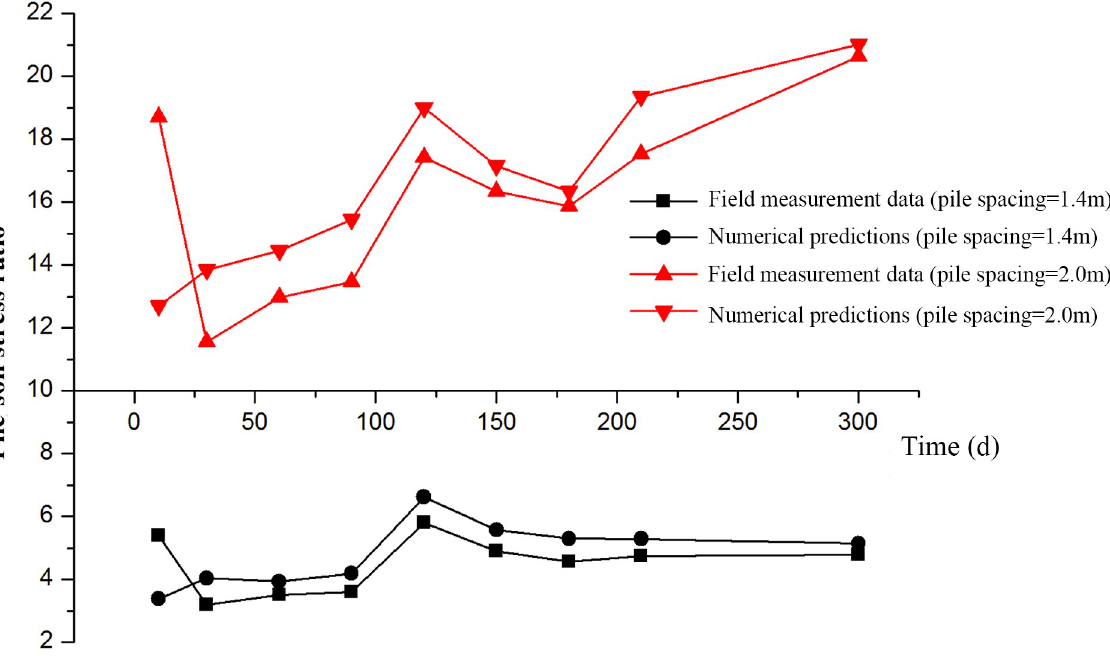
Fig 13. Effect of pile spacing on pile-soil stress